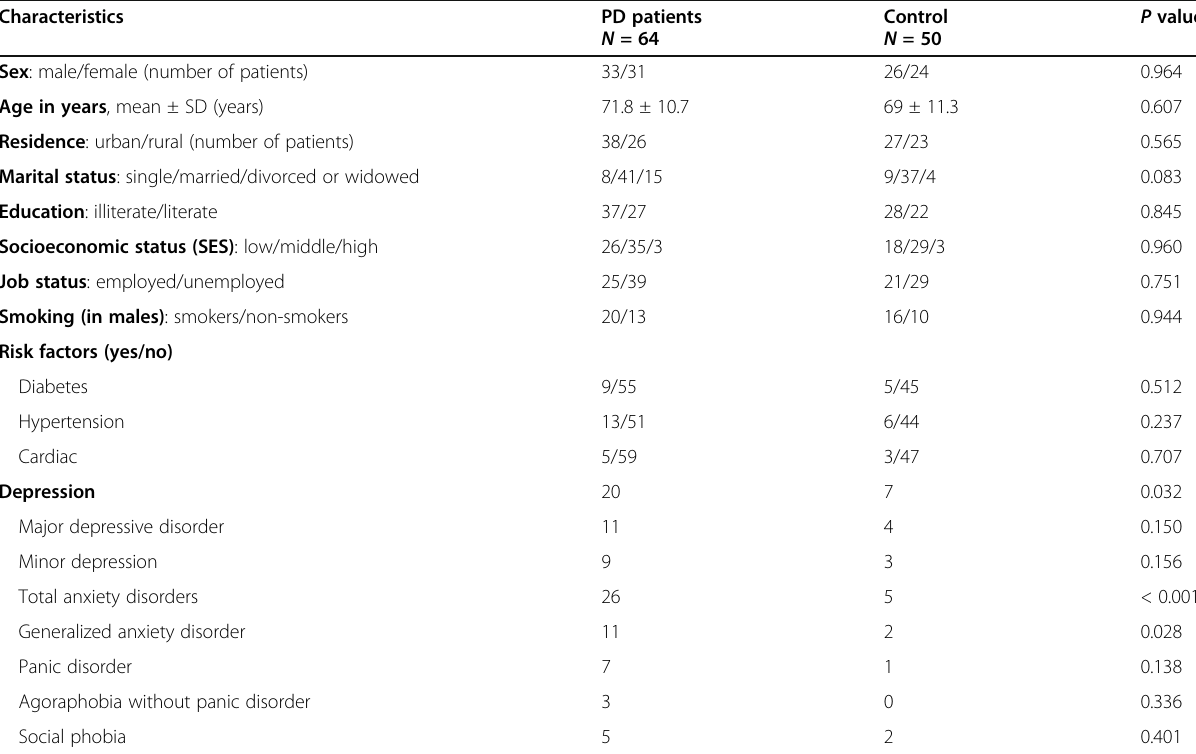
Table 1 Socio-demographic, medical history, and frequency of depression and anxiety among studied groups (patients and